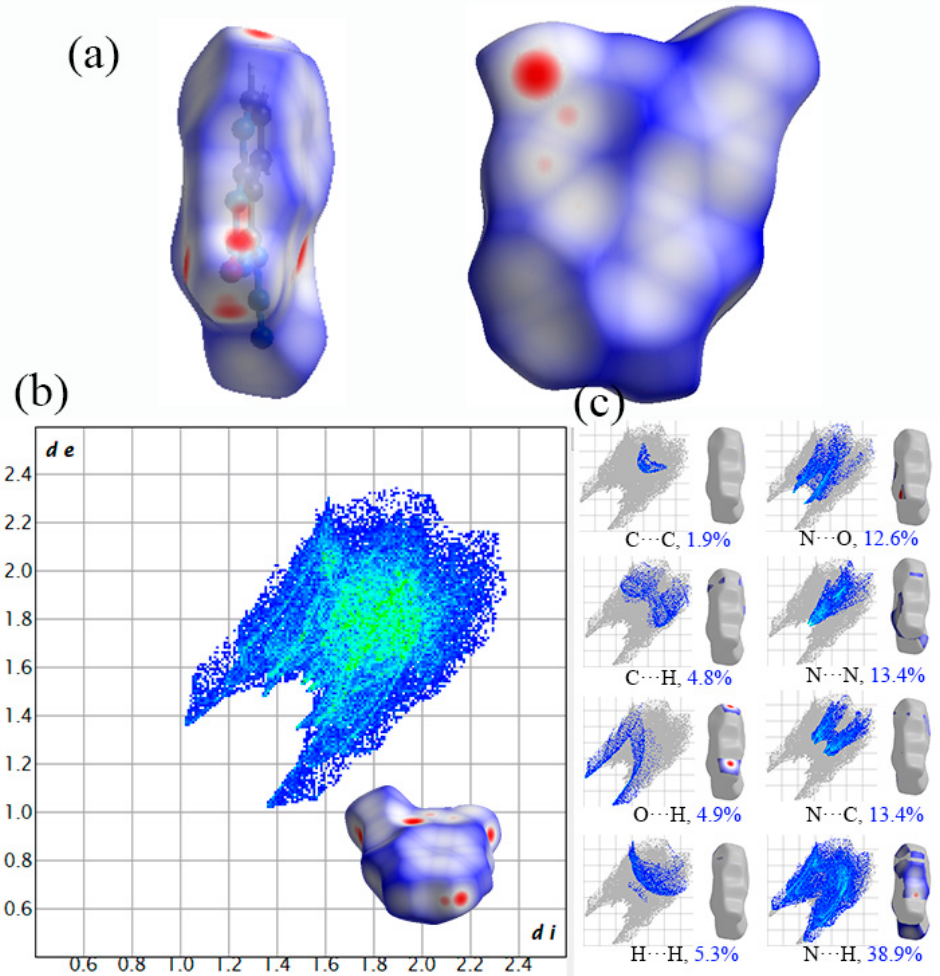
Figure 6. Hirshfeld surfaces and the corresponding 2D fingerprint plot of Crystal b : ( a ) Hirshfeld surfaces; ( b ) 2D fingerprint plots; ( c ) populations of close interatomic contacts.